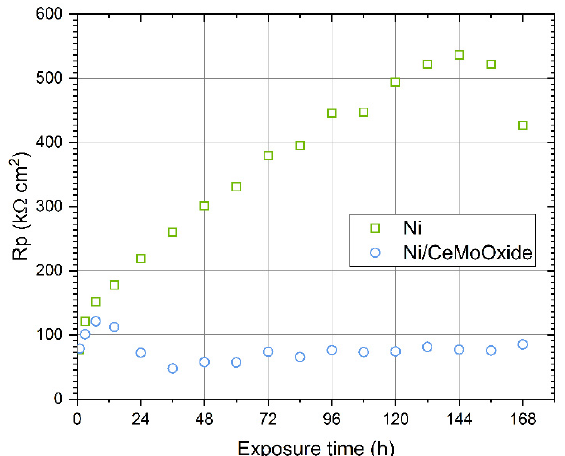
Figure 4. Polarization resistance ( R p ) recorded for blank and composite Ni coatings during 168-hour exposure in 0.05 M NaCl solution.